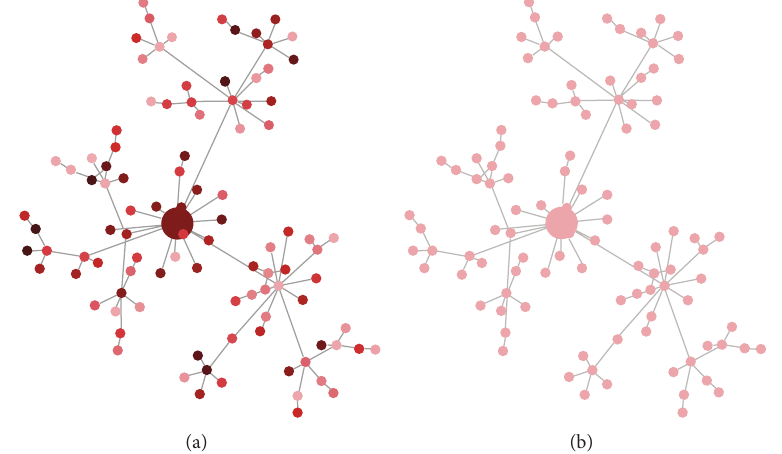
Figure 16: When 𝑎 = 0.6 , 𝑏 = 0.2 , 𝑐 = 0.2 , and 𝐼 𝑜 = 0.1 , external intervention influences the polarization of Internet group opinions. (a) Opinions distribution at 100 time steps; the opinion of opinion leader is − 0.6 now. (b) Opinions distribution at 1000 time steps; the opinion of opinion leader changes to